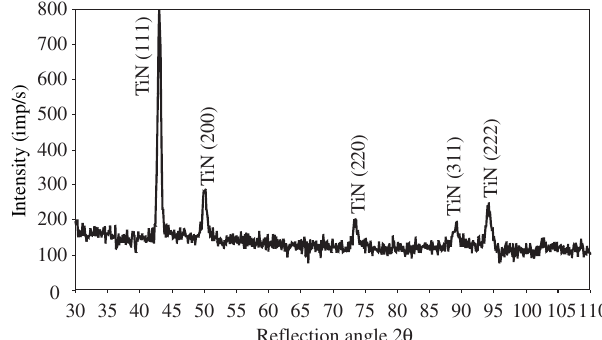
Figure 1. X-Ray diffractions pattern of the W1 type cemented carbides with the TiN/(Ti,Al,Si)N/TiN. the substrate (Figure 2). The scanning electron microscopic examina- tions also revealed that the single and multi-layer coatings obtained by PVD or CVD processes were even on the commercial cemented carbide and cermet surfaces. The coatings were compact without vis- ible pores and cracks and adhered well to the substrates (Figure 3). Only in the case of the single-layer TiN coating deposited using the PVD method on the W3 cemented carbide substrate, the coating thickness was uneven. The roughness of the coatings, defined by R , was in the range 0.60-0.67 µm and was significantly higher than